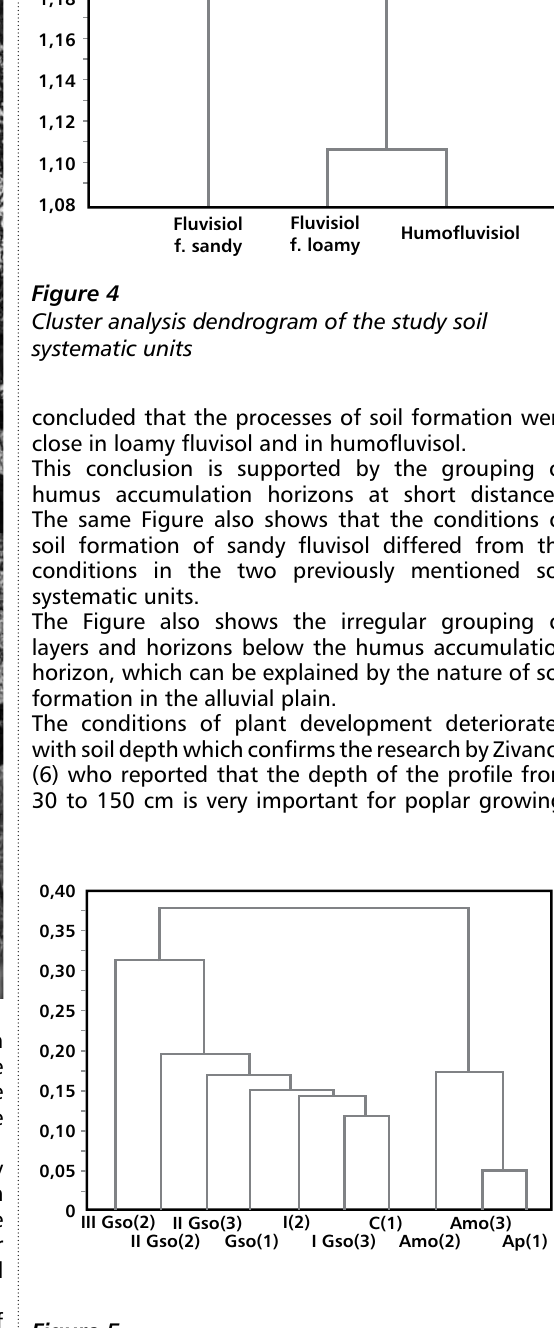
Figure 5 Cluster analysis dendrogram of the study soil horizons and layers (1* humofluvisol 2* sandy fluvisol 3* loamy